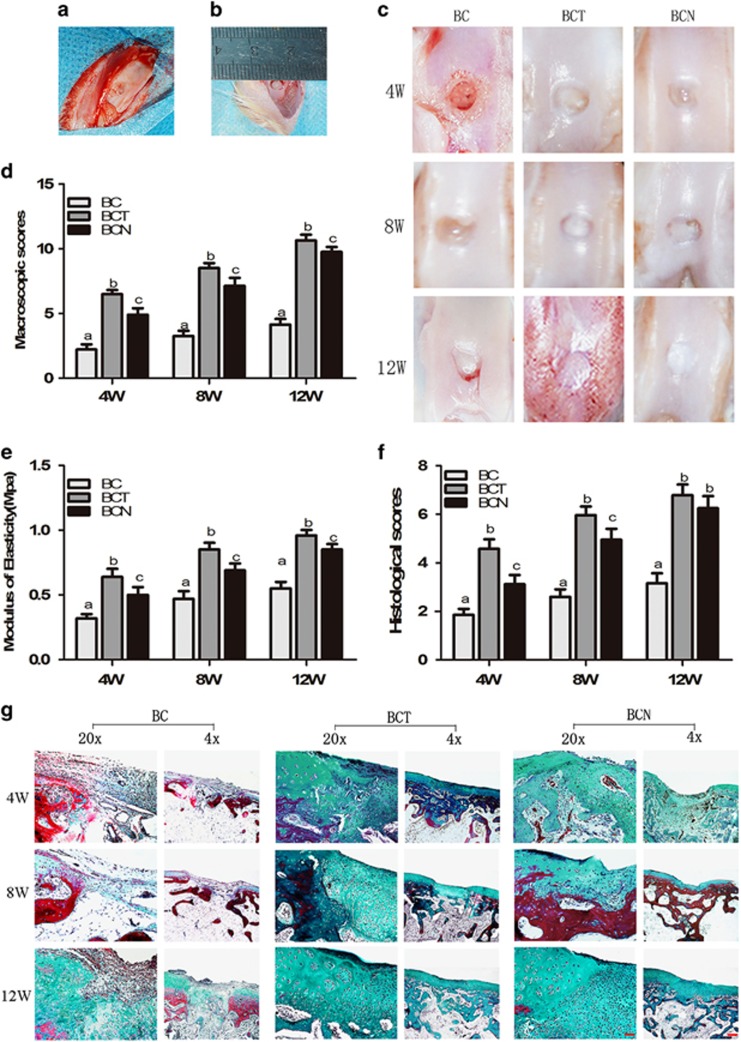
Chondrogenic effects of NGF on BMSCs in vivo. (a and b) Intraoperative photographs showed the location and size of the defect. (c) Macroscopic appearance of cartilage defect healing in the three groups at week 12 after surgery. (d) International Cartilage Repair Society macroscopic scores for all samples from the three groups at 4, 8 and 12 weeks after surgery. (e) Biomechanical testing. (f) Histological scores for the samples from the three groups at 4, 8 and 12 weeks after surgery, according to the scale described by Wakitani. (g) Masson’s trichrome staining were performed on cartilage sections. The values are means±S.D., n=10 joints; bars with different letters are significantly different from each other at P<0.05. (Original low magnification × 40 (scale bar, 500 μm); original high magnification × 200 (scale bar, 100 μm))